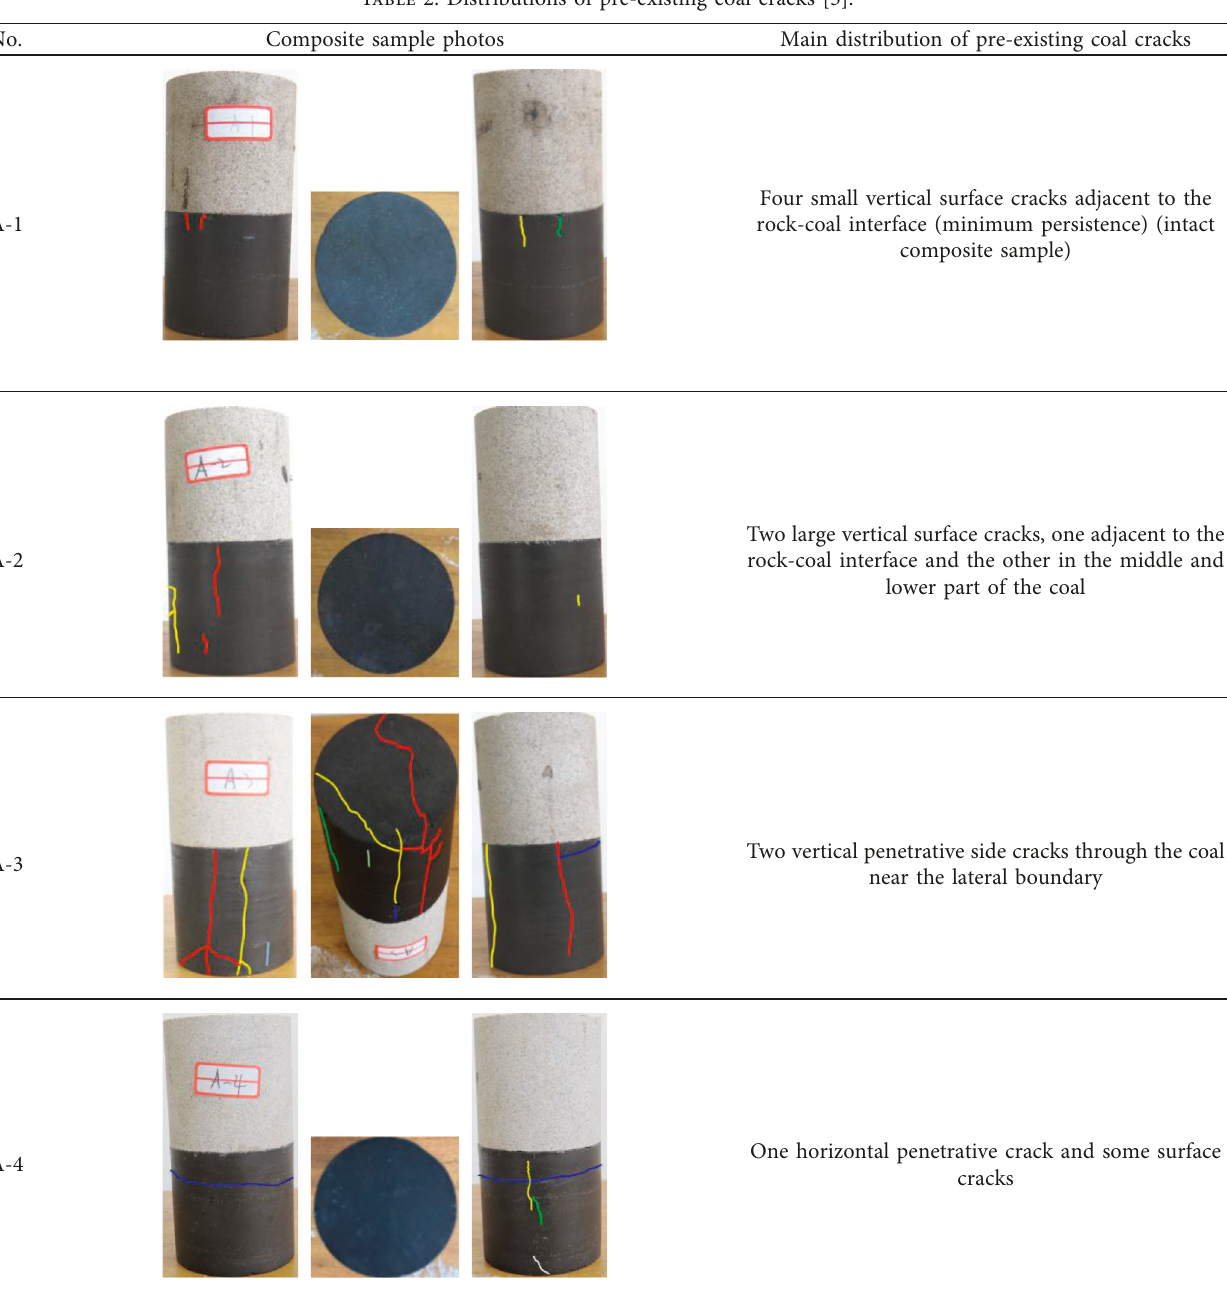
Table 2: Distributions of pre-existing coal cracks